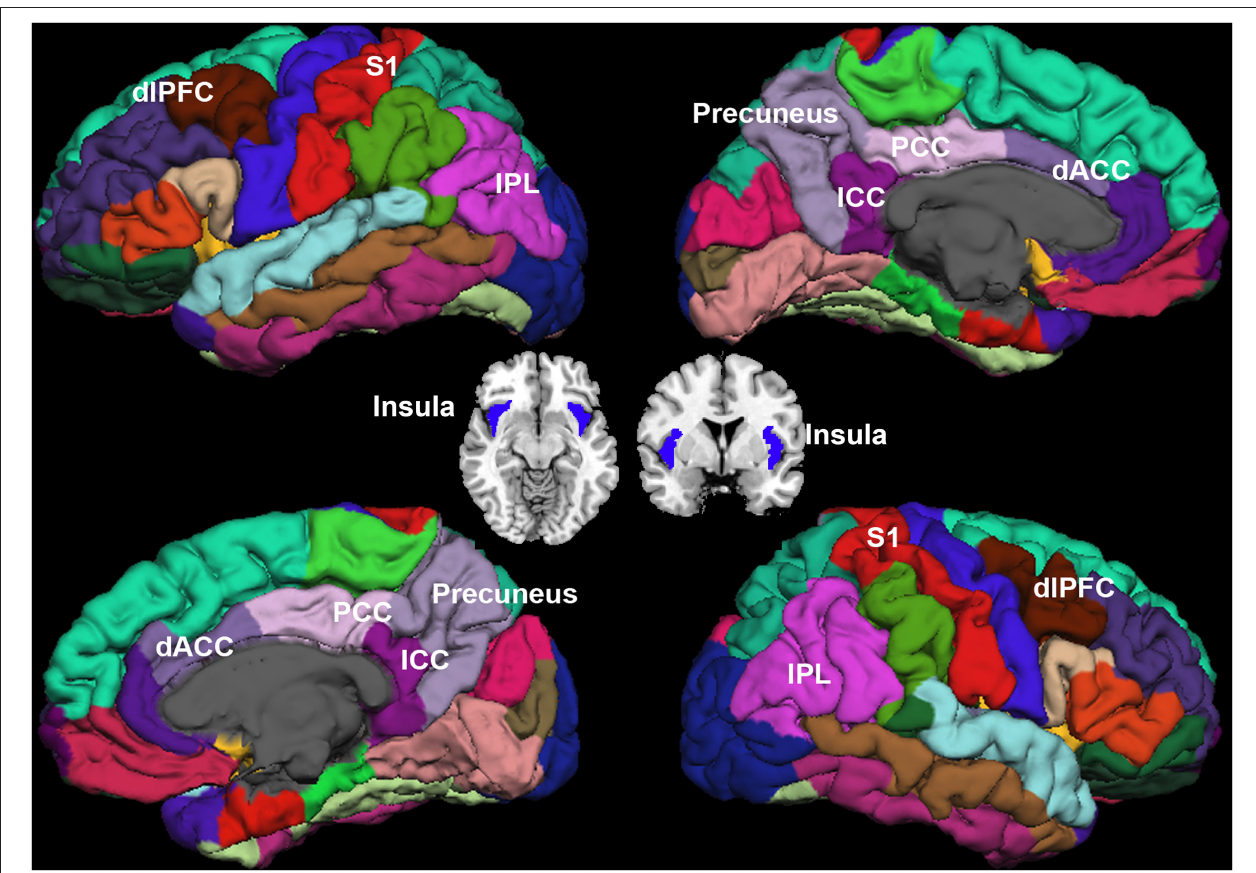
FIGURE 2 | Regions of interest. Sensorimotor network (SMN): bilateral post-central (S1), and bilateral insula. Salience network (SN): the dorsolateral prefrontal cortex (dlPFC), and bilateral dorsal anterior cingulate cortex (dACC). Default mode network (DMN): bilateral inferior parietal cortex (IPC), precuneus, isthmus cingulate cortex (ICC), and posterior cingulate cortex